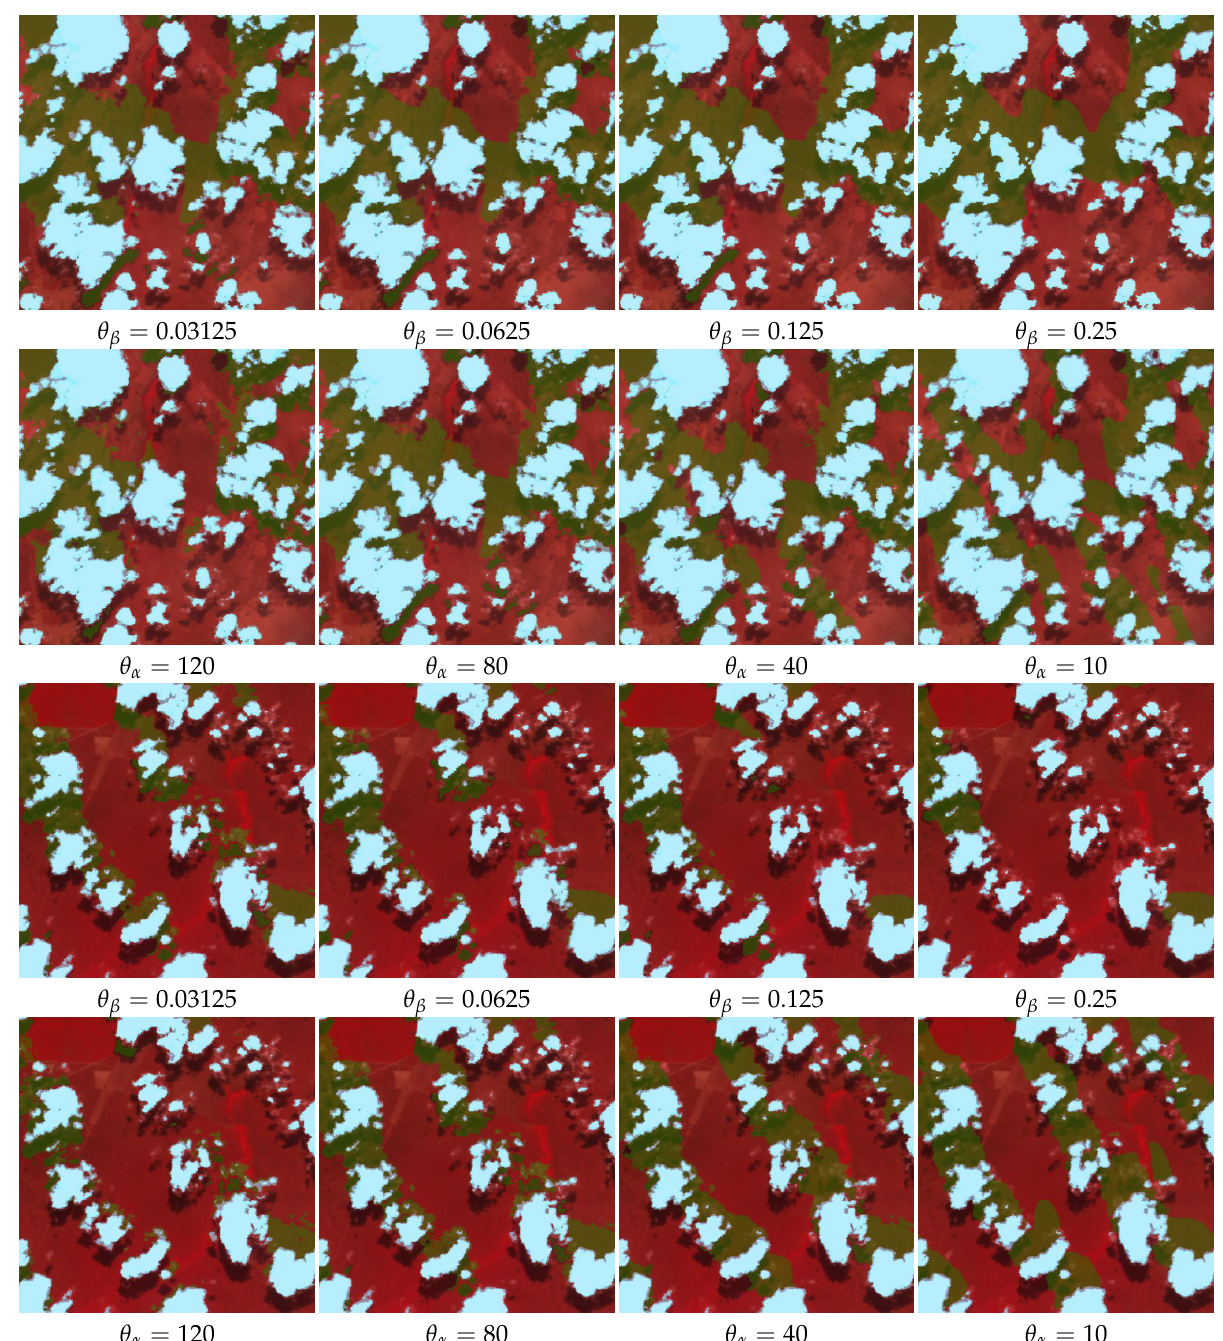
Figure 8. Illustrations of the effects of the critical hyperparameters (1). The typical patches are drawn from GF1WFV1.16m.2014267223114.21LTD.FAGUO1.SR.tiff. θ α and θ β are consistently reported